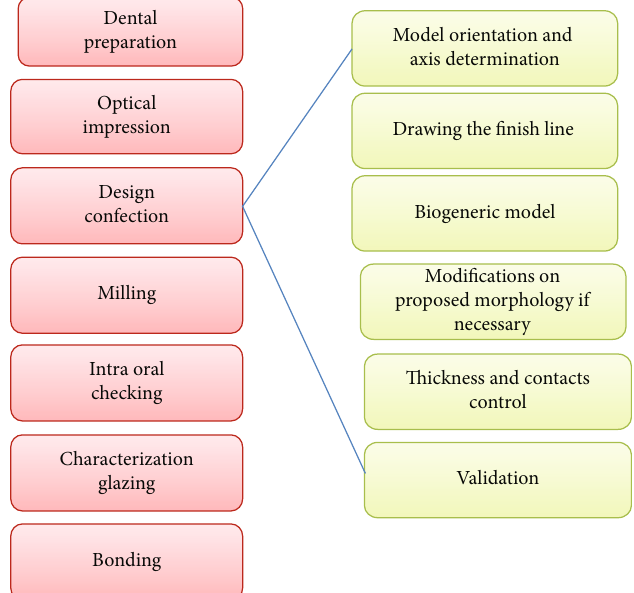
Figure 3: Chairside work fl ow.